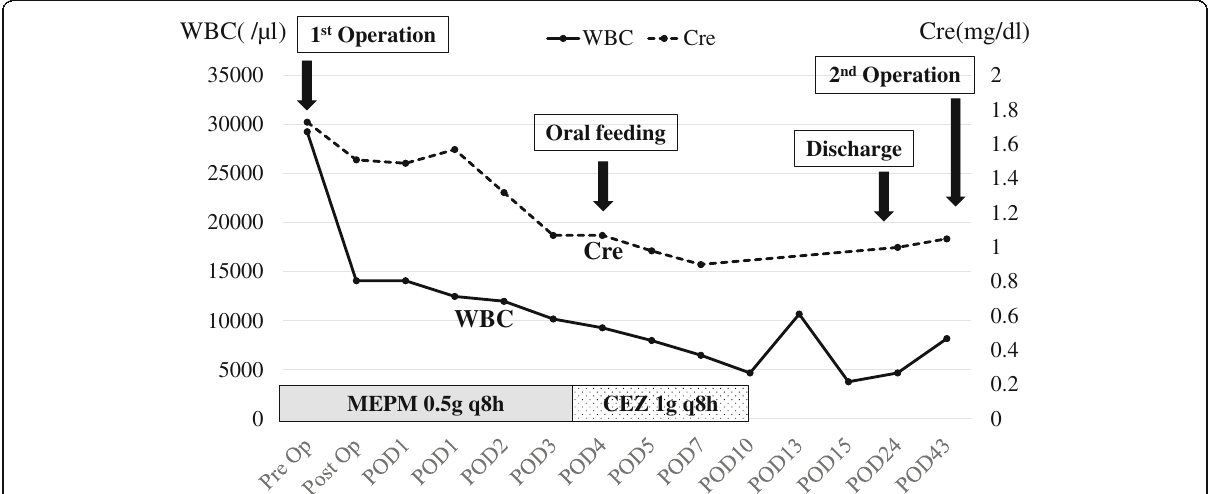
Fig. 4 The graph between the first and second operation. The inflammation reaction values and renal function returned to normal after the first operation. On POD 41, the second operation for the retroperitoneal tumor under the left kidney was